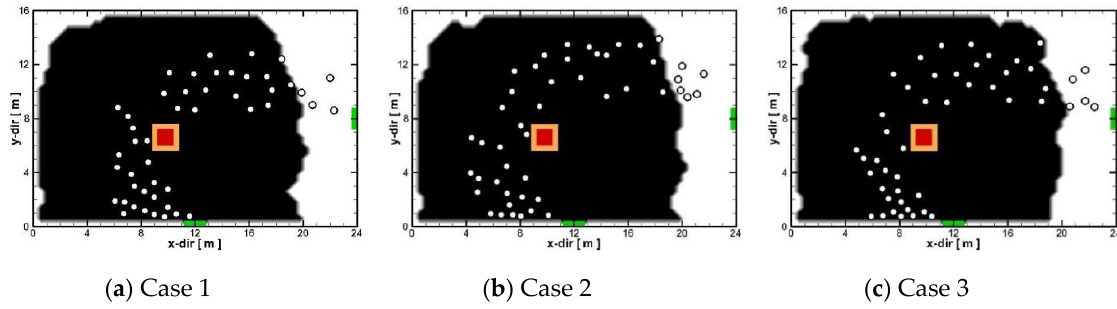
Figure 5. The distribution of the evacuees at 8 s.